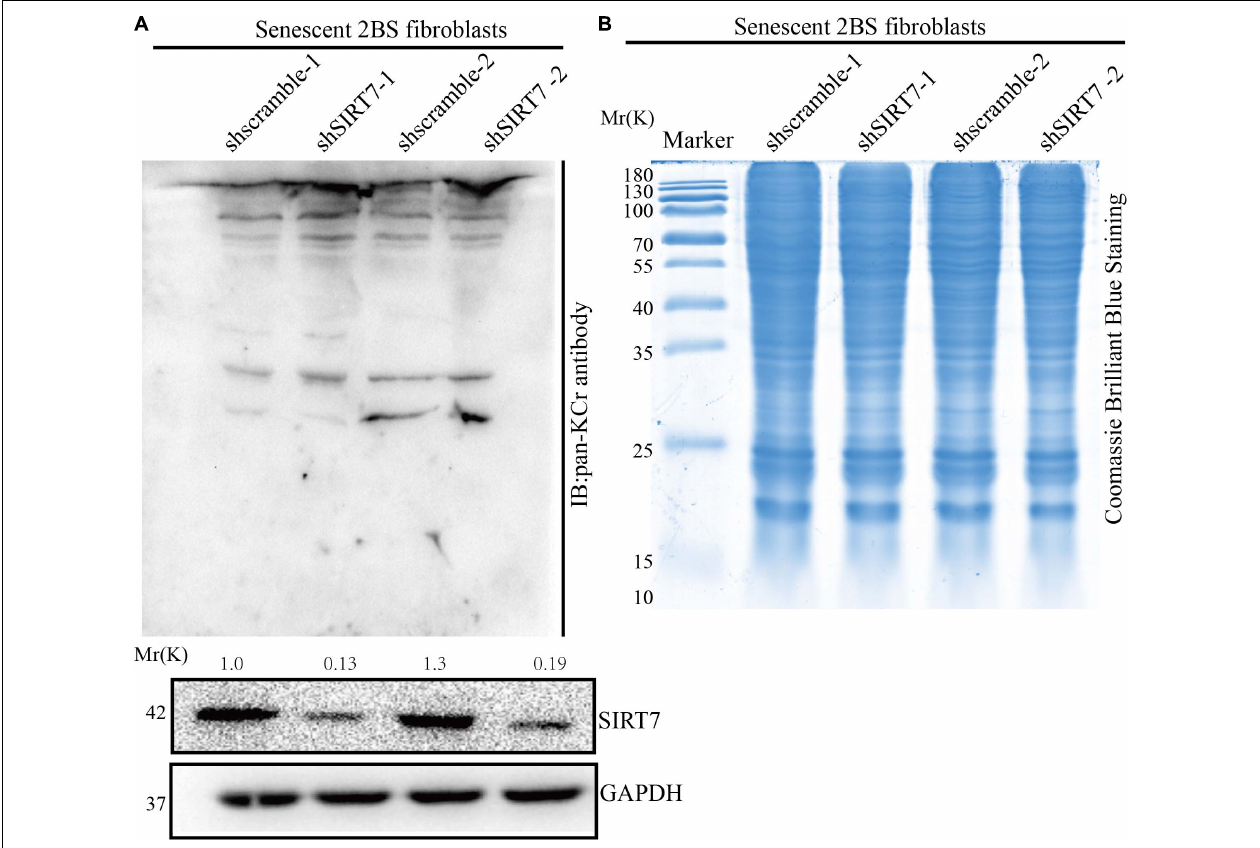
FIGURE 3 | Knockdown of SIRT7 altered pan-crotonylation level in senescent fibroblasts. (A) Pan-Crotonylation modification antibody was used to detect the pan-crotonylation level in shscramble and shSIRT7 senescent 2BS fibroblasts. (B) Coomassie brilliant blue staining of total protein of shscramble and shSIRT7 senescence 2BS fibroblast. All experiments were repeated three times